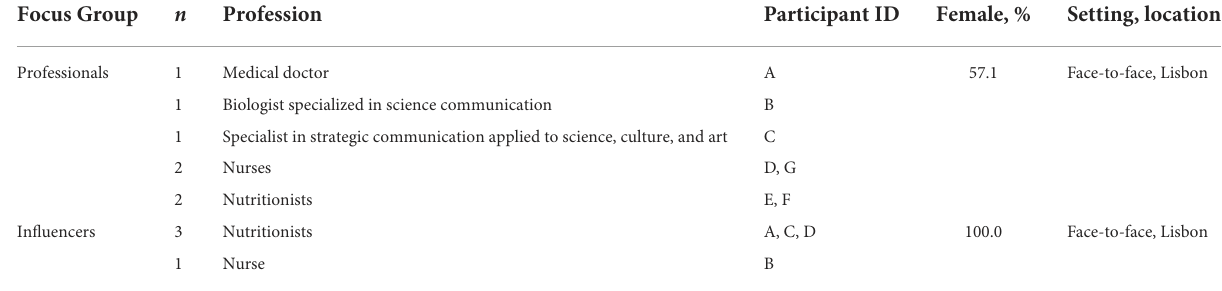
TABLE 2 Characteristics of the study participants included in the focus groups with health and communication professionals and digital influencers conducted to explore opinions and attitudes regarding the development of healthy eating promotion mass media campaigns. Focus